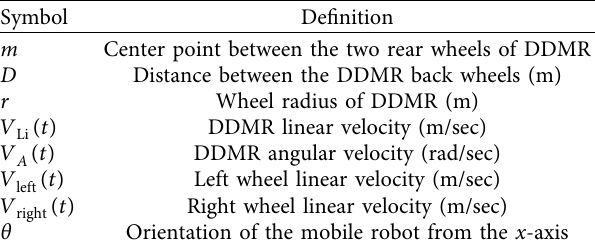
Figure 1: DDMR position representation in the world frame. Table 1: Parameters of the DDMR model